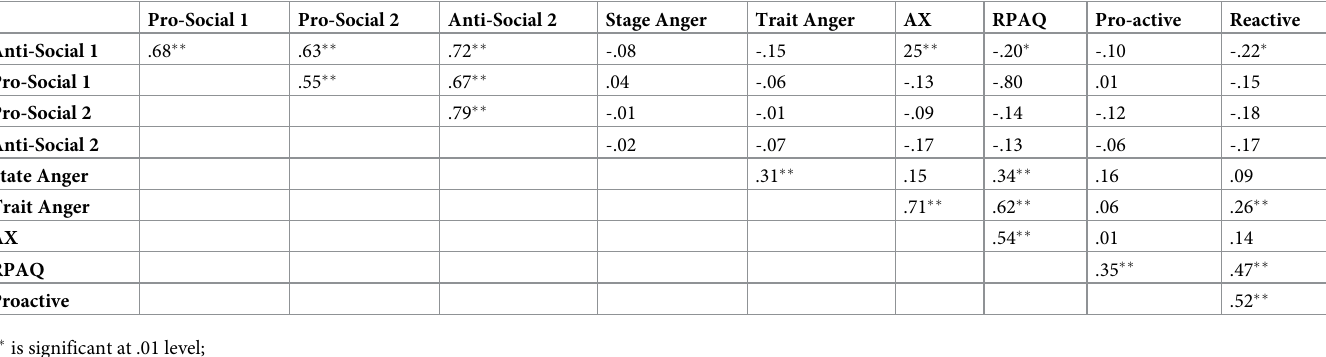
Table 2 illustrates the Pearson correlations between the IVR task and the traditional measures. Aggression in the anti-social 1 condition showed a significant negative correlation with the total anger expression index (AX) of the STAXI-2, as well as with the reactive past aggression self-report. Furthermore, the self-report STAXI-2 scales also correlated with past reactive aggression. We used Spearman’s correlation to determine none-parametric correlations with aggres- sion self-report measures and errors made in the IVR task, however, we did not find any signif- icant relationships (all ps > .05). Table 2. Pearson r correlations between IVR task and aggression